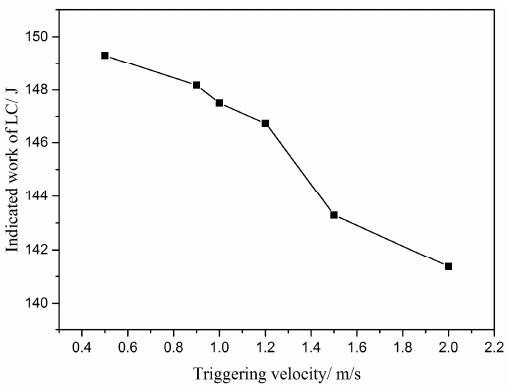
Figure 15. Indicated work variation of the LC for different values of the “triggering velocity” (experiment).